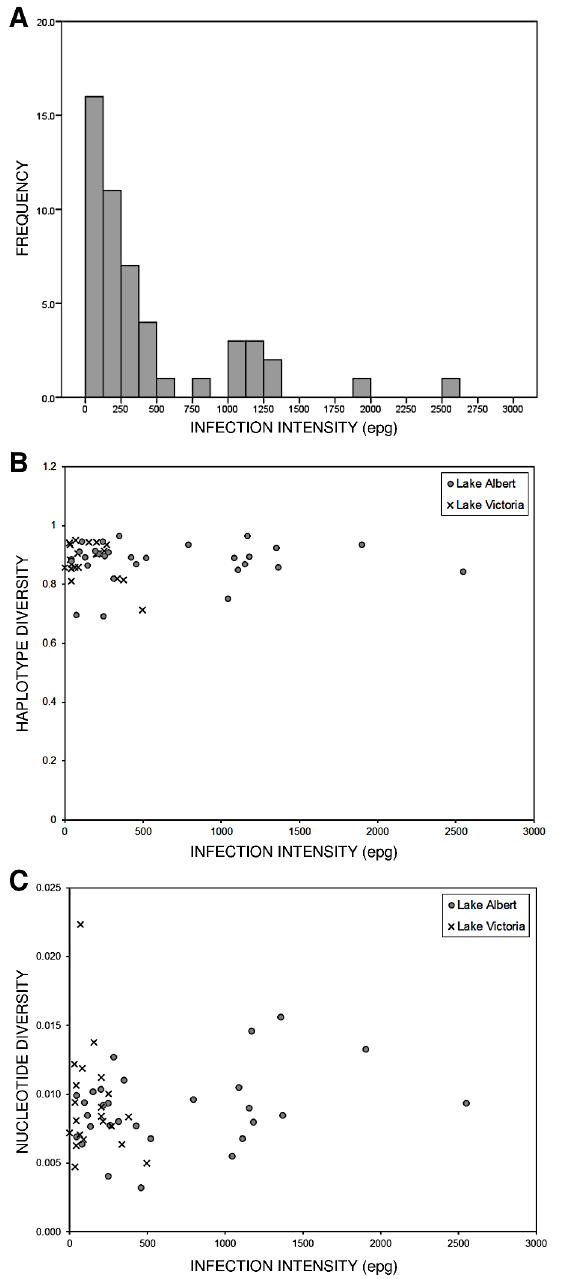
Figure 4. Relationship between infection intensity and genetic diversity at baseline. (A) Histogram displaying typical ‘‘overdis- persed’’ distribution of S. mansoni infections at baseline. (B) Haplotype diversity of parasites isolated from individual hosts plotted against host infection intensity. (C) Nucleotide diversity of parasites isolated from individual hosts plotted against host infection